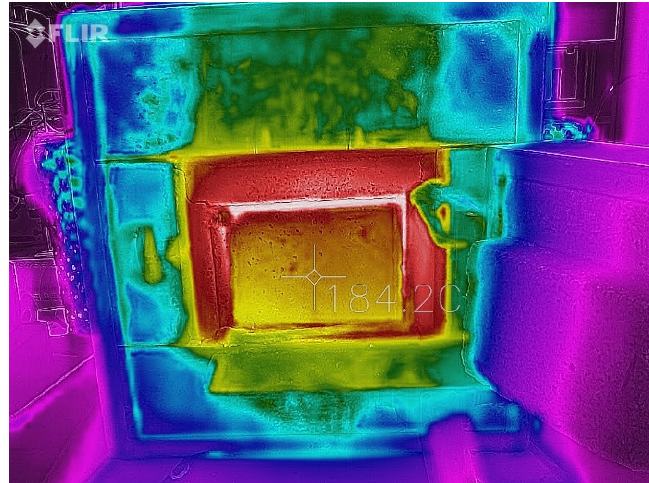
Figure 5. Sample photo of the measurement of thermal radiation.